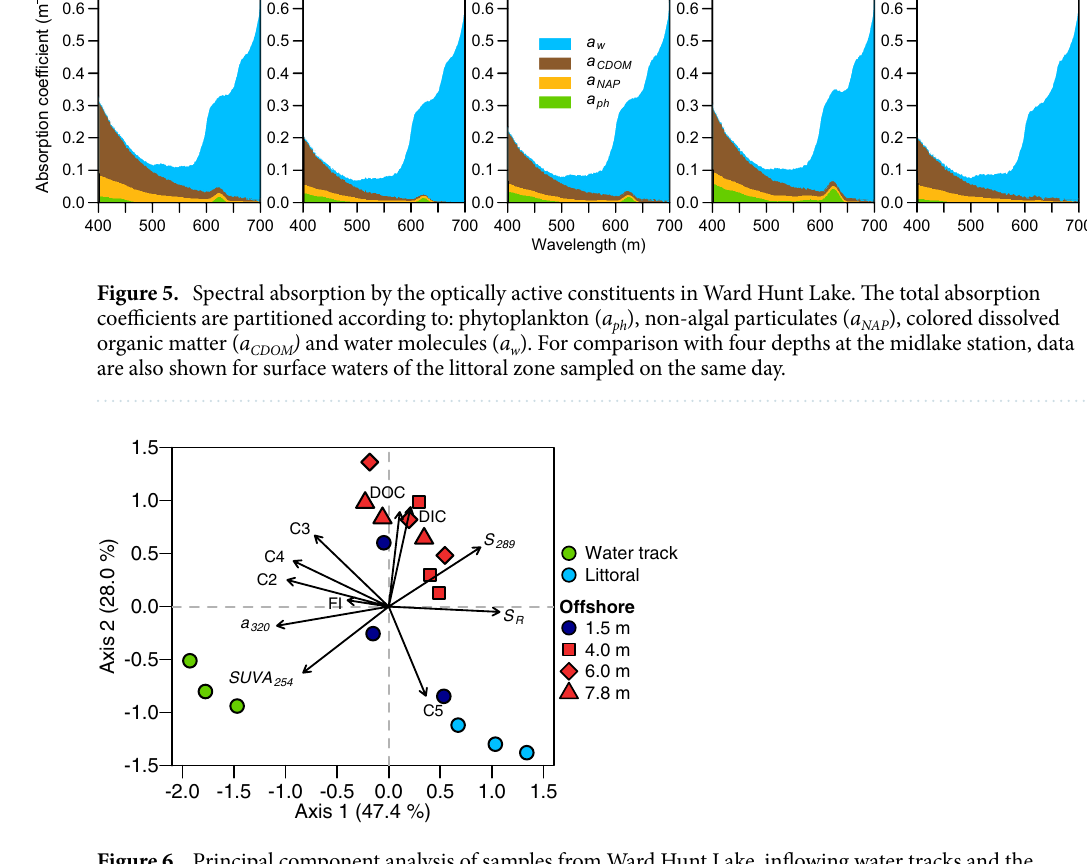
Figure 6. Principal component analysis of samples from Ward Hunt Lake, inflowing water tracks and the littoral zone in July 2017. DIC: dissolved inorganic carbon; DOC: dissolved organic carbon; a 320 : absorption coefficient at 320 nm; SUVA 254 : specific ultraviolet absorbance at 254 nm; S 289 : absorption slope parameter between 279 and 299 nm; S R : absorption slope ratio; FI : fluorescence index; C1 to C5: contribution of the five components identified by the PARAFAC model. Water tracks are subsurface flow paths draining the west side of the